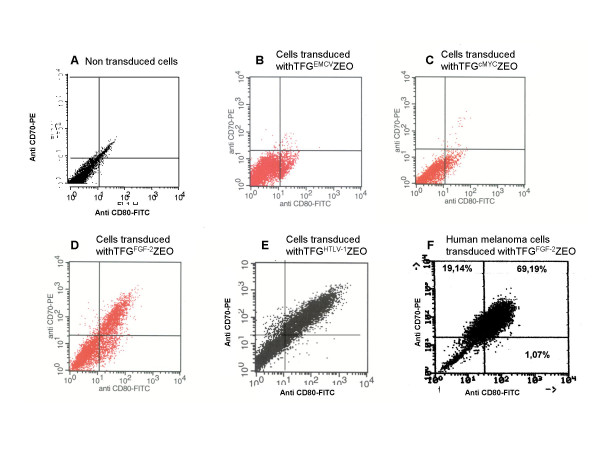
Example of co-stimulatory molecule expression by melanoma cells after transduction with TFG tricistronic vector: Immunostaining with hCD80 –(x-axis) and hCD70 – (y-axis) 3A: non transduced melanoma cells were cultured. Ccells (3 × 105) was stained for surface expression of CD70 and CD80 using specific antibodies as described in the Methods. 3B-3E: Murine B16.F10 melanoma cells were transduced with the four TFG retroviral vectors. Forty eight hours after transduction, pools of cells (3 × 105) were stained for surface expression of CD70 and CD80 using specific antibodies as described in the Methods. 2B: TFGEMCVZEO transduced cells, 2C: TFGc-MYCZEO transduced cells, 2D: TFGFGF-2ZEO transduced cells, 2E: TFGHTLV-1ZEO transduced cells.3F: Human melanoma cells were transduced with the TFGFGF-2ZEO. A selected pool of cells (3 × 105) was stained for surface expression of CD70 and CD80 using specific antibodies as described in the Methods. The samples were subjected to two-color analysis by flow cytometry. Data are shown as immunofluorescence profiles with arbitrary fluorescence units (log) of FITC on the x-axis and immunofluorescence profiles with arbitrary fluorescence units (log) of PE on the y-axis. To evaluate the percentage of co-stimulatory molecules expressed by transfected cells, the marker was set to allow < 5% positive cells in the non-transduced cells.